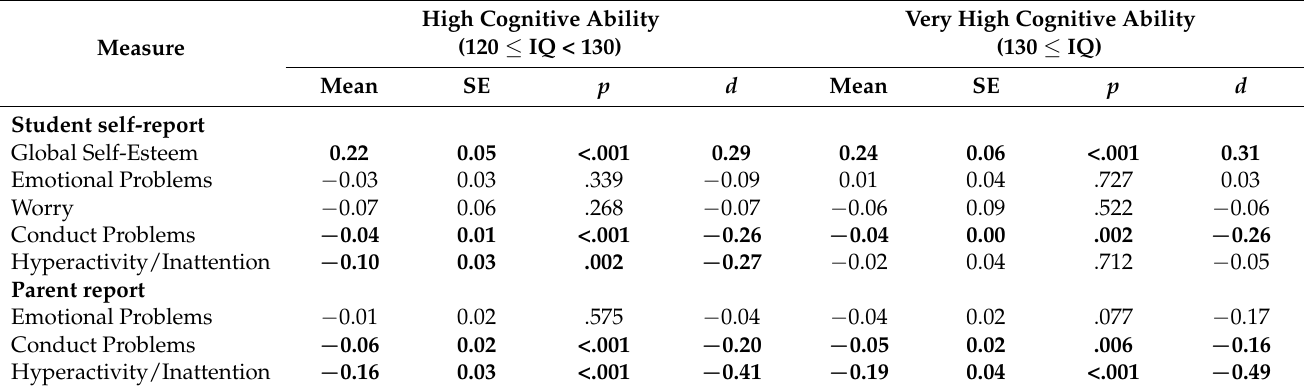
Table 3. Latent means of mental health indicators in adolescents with high and with very high cognitive ability. Latent means fixed to zero for average ability